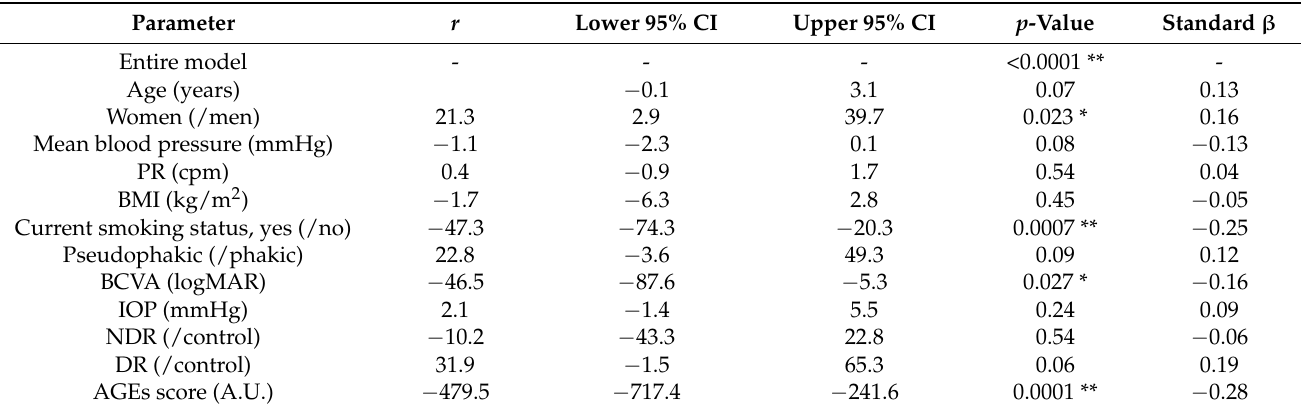
Table 10. Possible associations among Veggie scores (O.D.) and various parameters analyzed by multiple regression